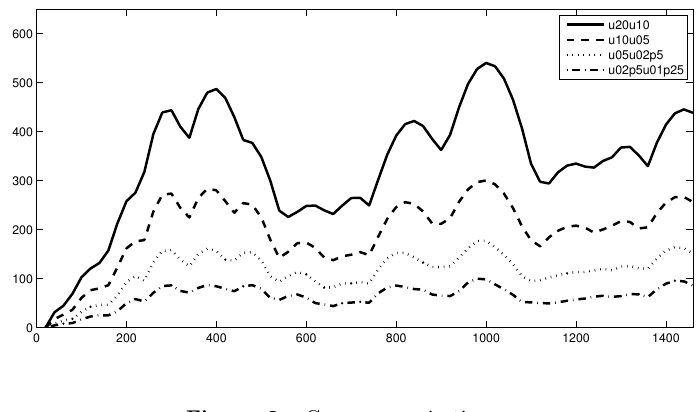
Figure 2. Convergence in time.